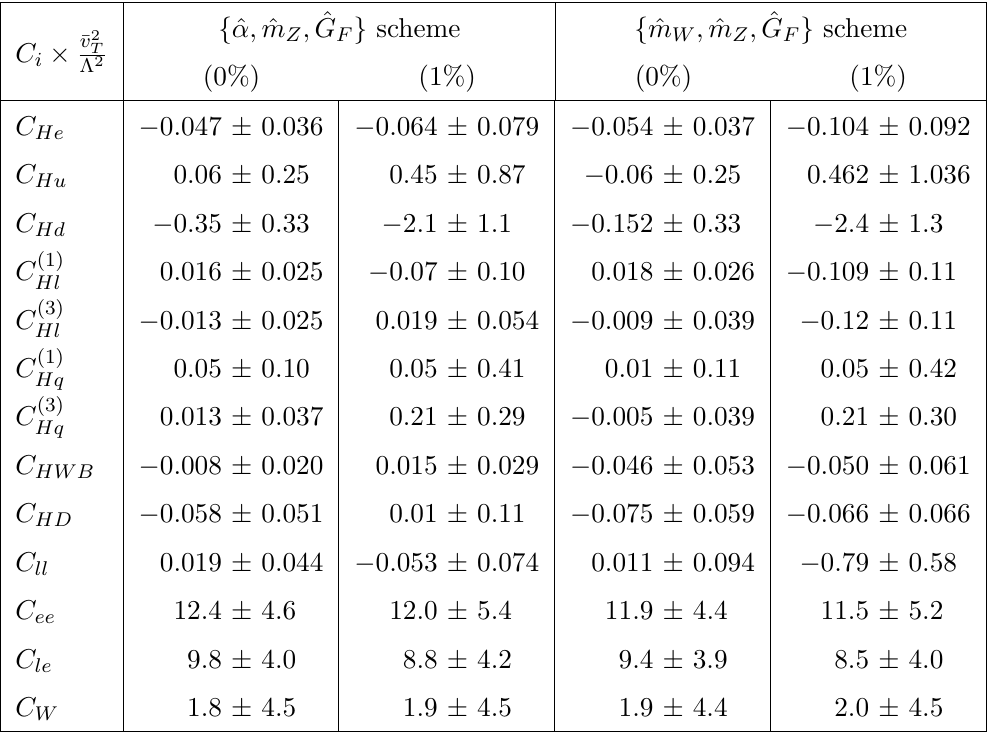
Table 6 . Best (cid:12)t values and corresponding 1 (cid:27) con(cid:12)dence regions for (cid:1) the two input parameter schemes considered in this work. These numbers have been obtained mini- mizing the (cid:31) 2 with one parameter at a time (despite the non-minimal character of the SMEFT [105]), and they have been multiplied by a factor